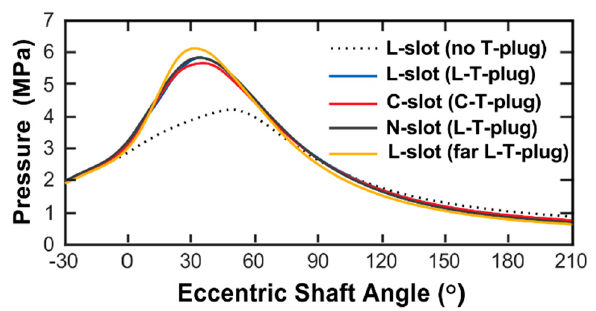
Figure 11. Simulated mean in-chamber pressure for different configurations of a slot and T-plug.